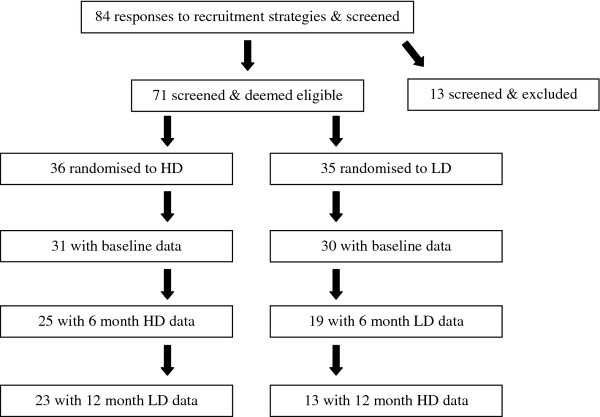
Participant flow and attrition. Participant flow through the study, showing study design with participant progression and attrition following initial randomisation to the HD and LD diets. HD, high dairy; LD, low dairy.